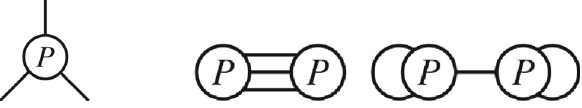
Fig. 1 Left: the diagram for the interaction vertex φ j φ j c . Right: the diagrams obtained by evaluating (28) through b